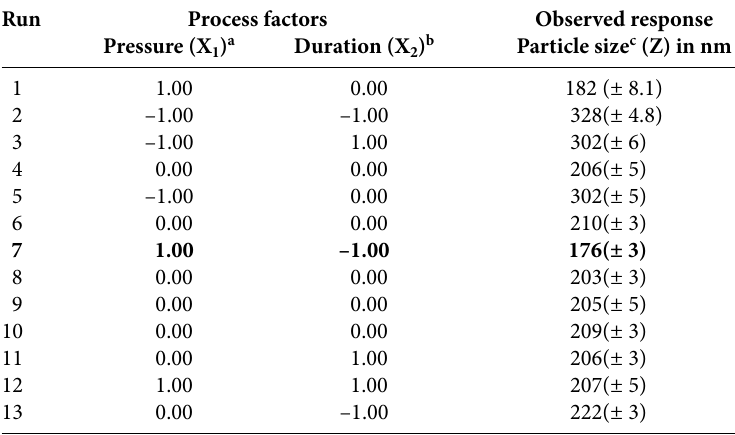
Table 1. Process variables and the observed response using 3 2 factorial design